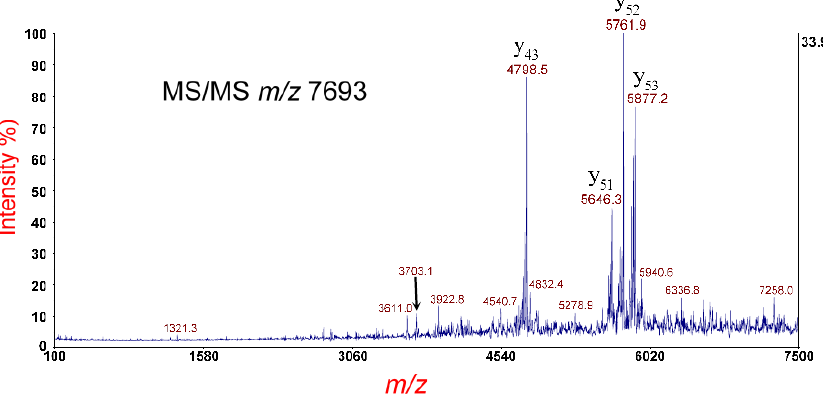
Figure 6. Top panel: MS analysis of E. coli O145:H28 strain RM14496-C1 cultured overnight on LBA supplemented with 800 ng / mL of mitomycin-C and disulfide-reduced. The putative disulfide-reduced B-subunit of Stx1a is indicated. Bottom panel: MS / MS analysis of the putative B-subunit at m / z 7693 in the top panel. Fragment ions are indicated by their m / z and y-type designations. The sequence of the Stx2a B-subunit is shown. A red asterisk indicates sites of polypeptide backbone cleavage that generate the corresponding fragment ions shown above (y-type) or below (b-type) the sequence. Acidic residues are highlighted in red and basic residues in blue. Cysteine residues are boxed.